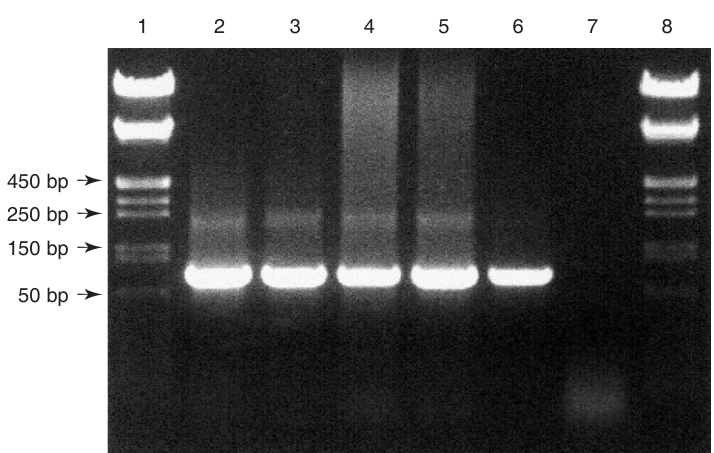
FIG. 5 PCR amplified products of PBFDV (P- BLM-4) from samples collected on fil- ter paper, followed by DNA extraction after 24 [lane 2], 48 [lane 3], 72 [lane 4] and 96 h [lane 5]. Lane 6 contains the PCR product of a sample (P- GEO) that was received on commer- cially available specimen collection paper and processed after 1 month. Lanes 1 and 8, contains a molecular mass marker ( λ Eco R1/ Hind III), and lane 7 a negative control from a sam- ple that was shown to be negative (B-